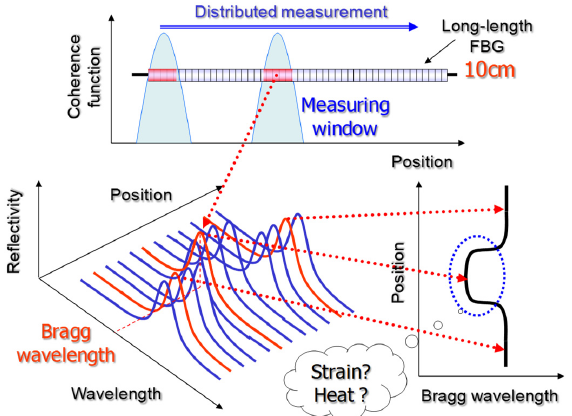
Figure 12. Measurement of Bragg wavelength distribution along a long-length FBG with SOCF technology [29].